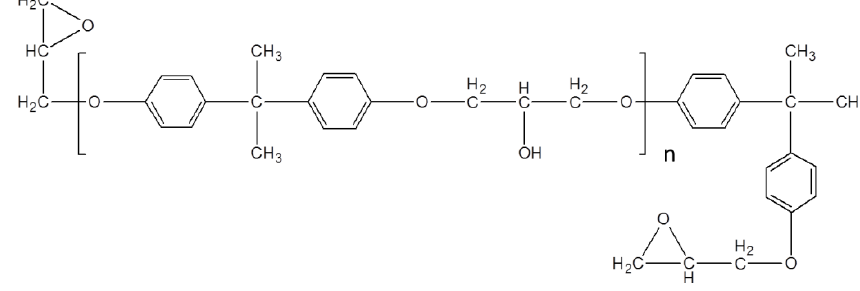
Figure 1. The molecular structure of epoxy E-51.